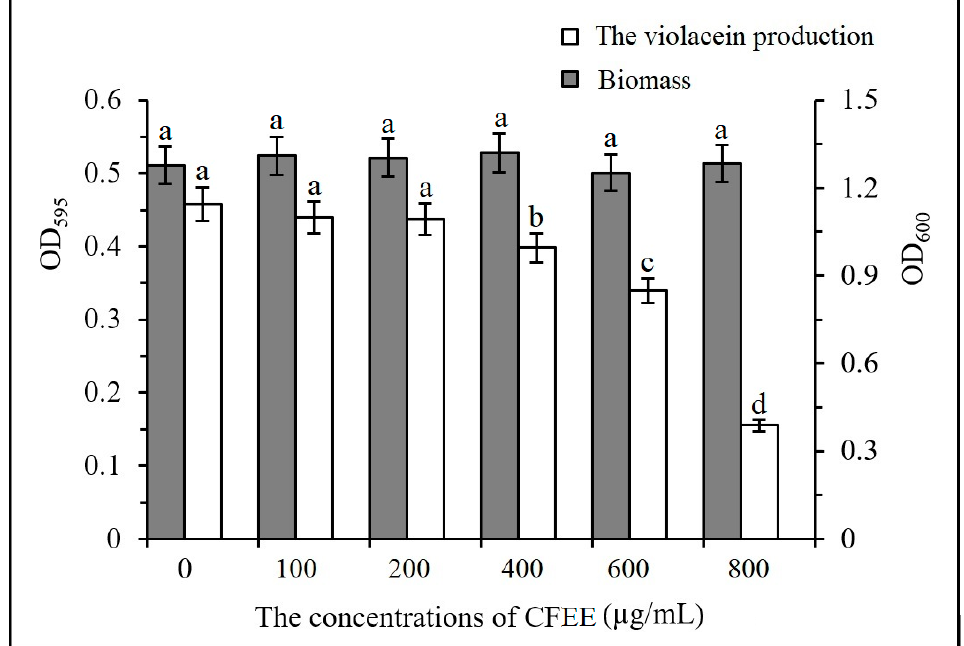
Figure 2. Biomass and violacein production of C. violaceum 026 when it was incubated in the LB medium with different concentrations of CFEE. Each bar represents the standard deviations of five measurements. Different letters indicate significant differences in inhibition rates.